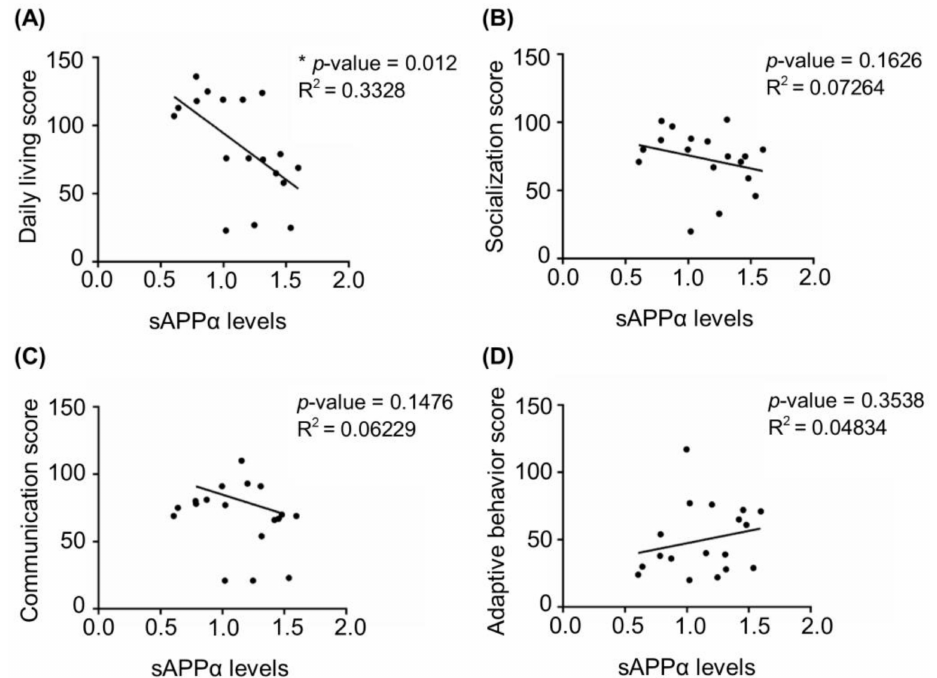
Figure 2. Correlation between four main domains of Vineland adaptive behavior scale and sAPP α levels in FXS. ( A ) Daily living score, ( B ) socialization score, ( C ) communication score, and ( D ) adap- tive behavior score of FXS individuals were plotted against the levels of sAPP α detected in fi- broblasts from 18 individuals described in Figure 1 (see Materials and Methods and Table S1 for details)(* p < 0.05, Spearman correlation